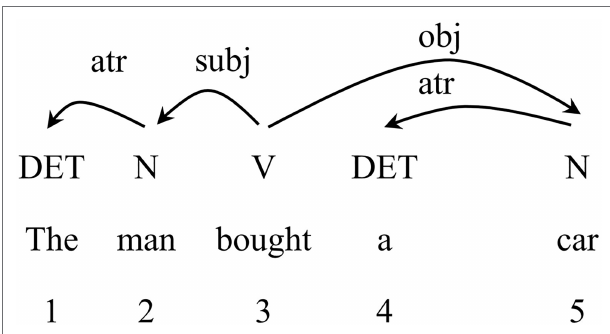
FIGURE 2 | Dependency structure of sample sentence “ The man bought a car. ”